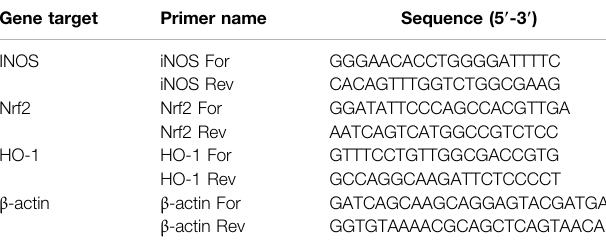
TABLE 1 | Primers for real-time PCR used in this